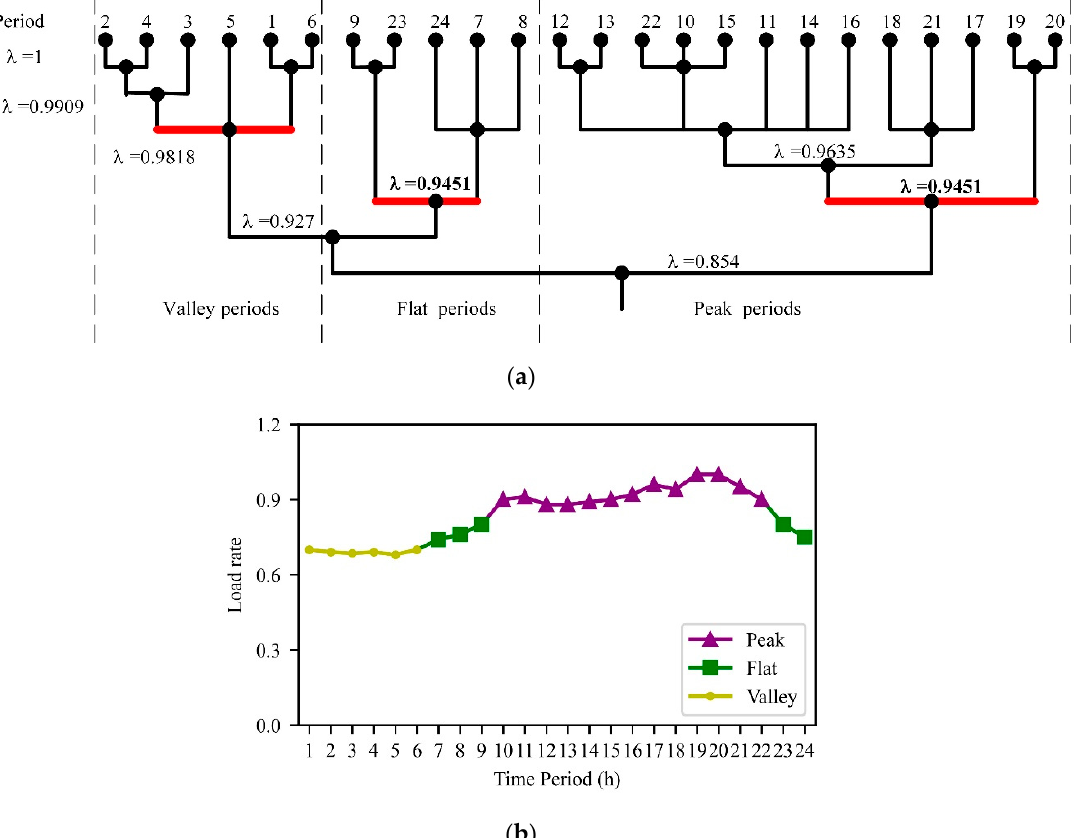
Figure 5. Identification of peak, flat, and valley periods. ( a ) Dynamic clustering graph; ( b ) division results of peak, flat, and valley periods.